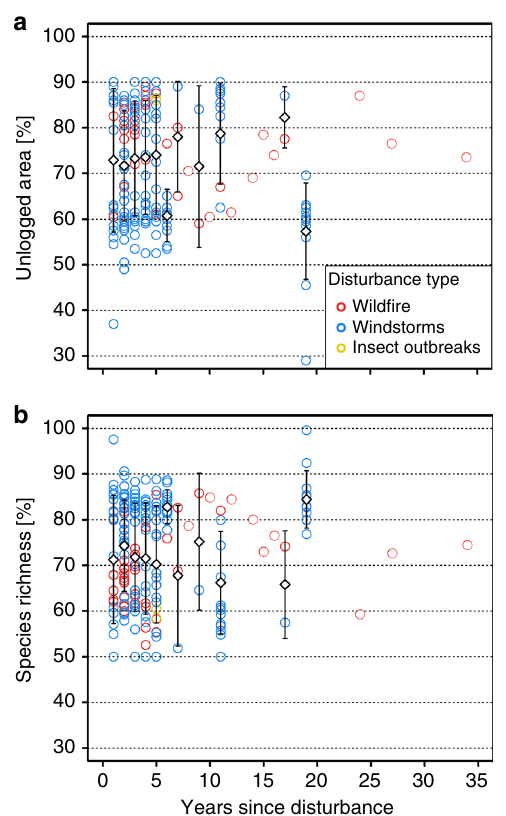
Fig. 5 Response of retention benchmarks to time since disturbance. Distribution (scatterplot) and annual mean values (white diamonds) with corresponding standard deviation across years for: ( a ) the retention area needed to maintain 90% of species unique to unlogged naturally disturbed forest; and ( b ) the portion of species unique to unlogged naturally disturbedforest that are maintained if 50% of the disturbed area is salvage logged. Source data are provided as a Source Data fi